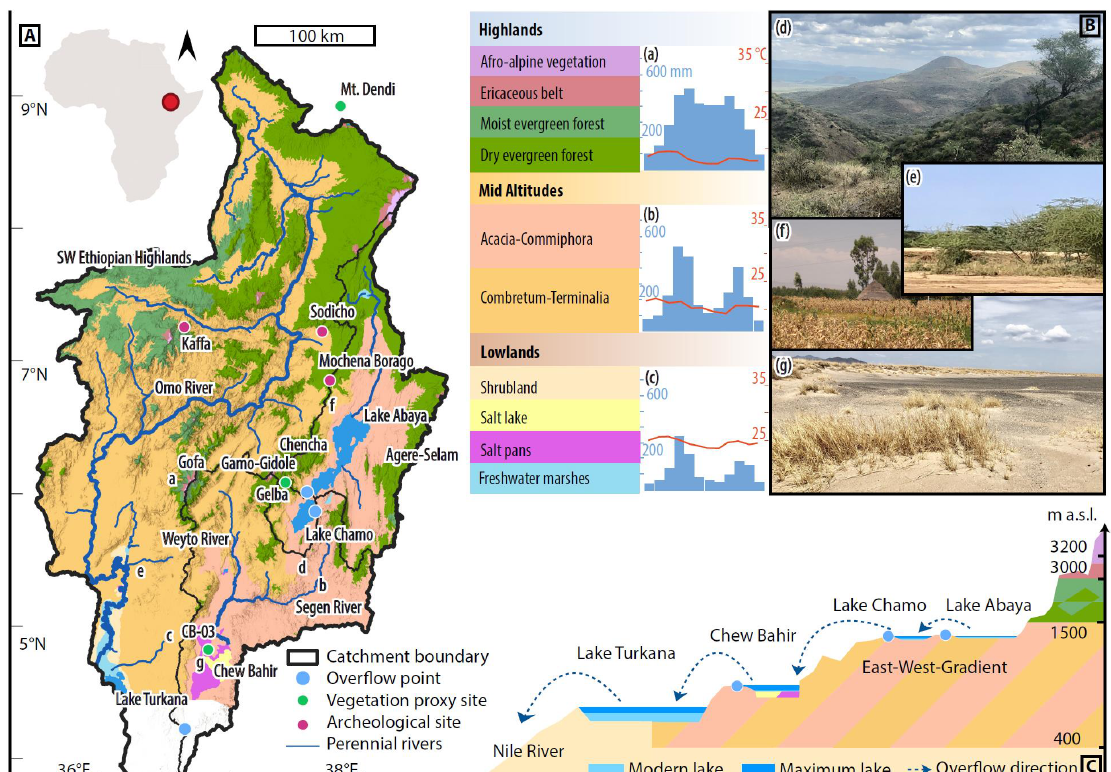
Figure 1. Overview of the study area with sites mentioned in the text, investigated lakes, overflow dynamics and modern- day potential vegetation. ( A ) Catchment of the Omo River, lakes Abaya and Chamo and paleo-lake Chew Bahir with lake’s overflow locations. Hill-shaded potential vegetation is based on Friis, et al. [3]. ( B ) Legend of potential vegetation arranged by altitude with (a to c) monthly temperature means in °C and precipitation in mm per month (IRI, last accessed 12/2020). The locations of the photographs of representative vegetation regimes (d to g, photos from Annett Junginger) are marked on the catchment map. ( C ) Cross-section from Lake Abaya to Lake Turkana showing the overflow direction and lake ladder with their prevailing potential vegetation (numbers correspond to the potential vegetation types marked on A and B).